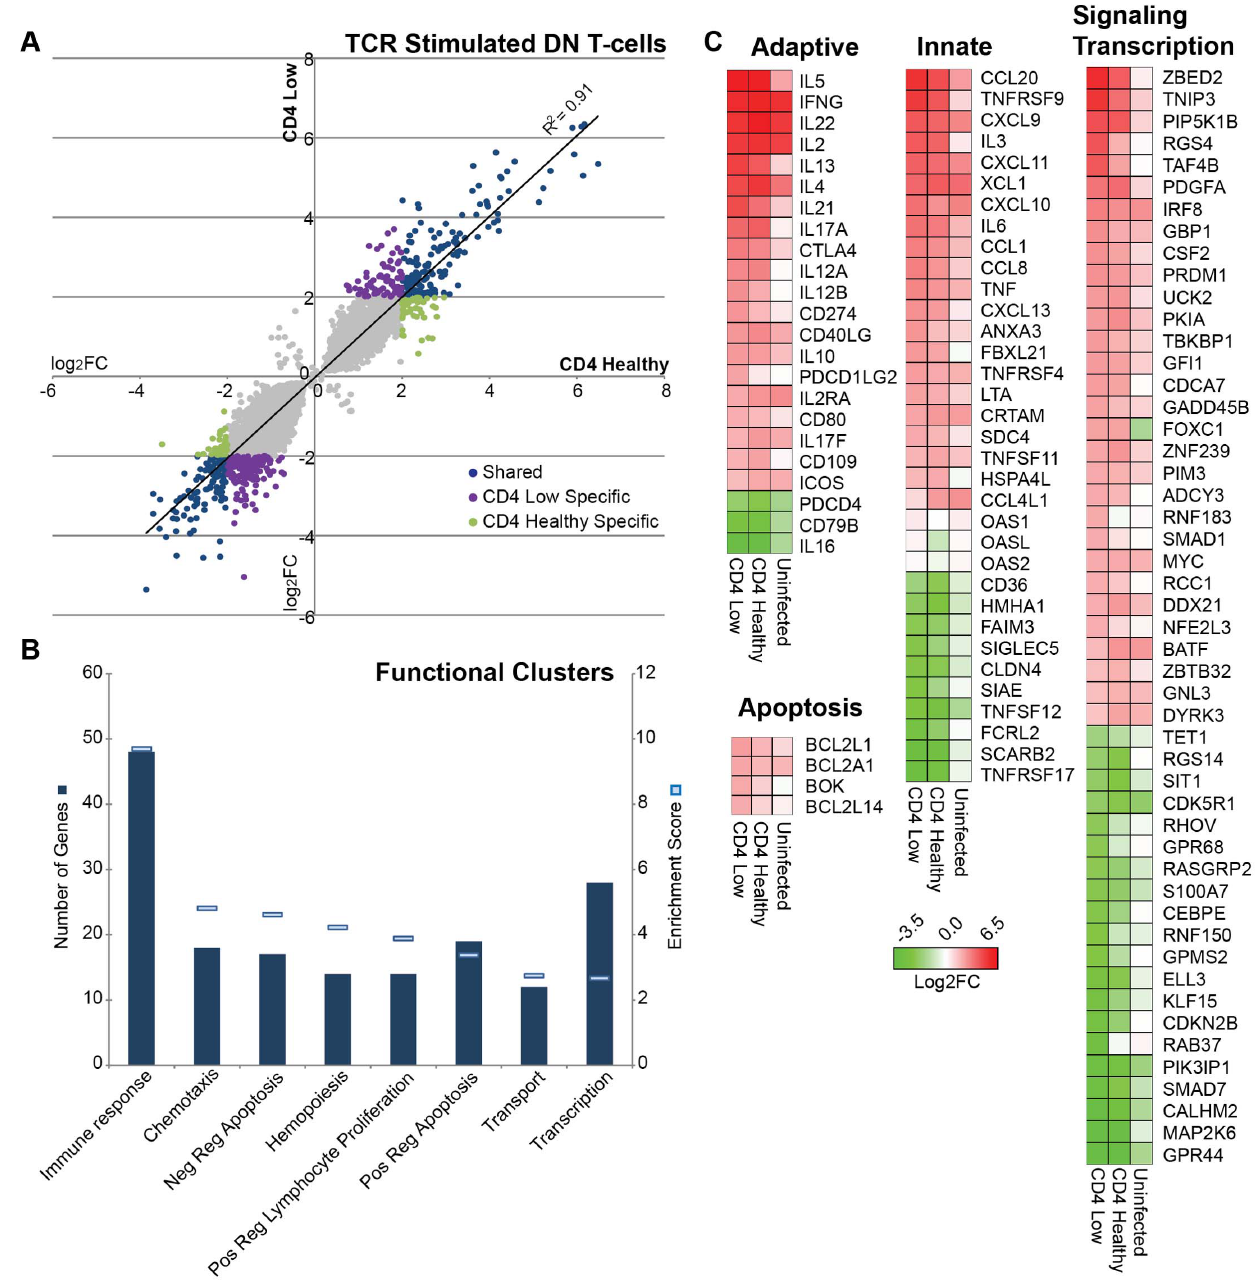
Figure 4. Transcriptome analysis utilizing microarray of TCR stimulated DN T cells from mangabeys depicts upregulation of transcription factors and immunomodulatory genes. Microarray analysis comparing TCR-stimulated and unstimulated DN T cells. A) DN T cells from two SIV + CD4-healthy and two SIV + CD4-low mangabeys were stimulated with anti-CD3/anti-CD28 and comparative mRNA expression of differentially regulated genes following stimulation of is depicted with less than 4 fold differential regulation depicted in grey, while those with greater than 4 fold differential expression depicted in color (n=568). In blue are genes regulated to the same extent in DN T cells from both SIV + CD4- low and SIV + CD4-healthy mangabeys, while genes specific to DN T cells from SIV + CD4-low animals are depicted in purple and those specific to DN T cells from SIV + CD4-healthy animals are in green. B) Enrichment data of functional clusters in gene families that are differentially regulated upon stimulation with number of genes shown as columns (dark blue) and extent of enrichment of functional gene clusters (enrichment score) depicted as lines (light blue). Genes involved in immune response and transcription were highly enriched. C) Evaluation of immunomodulatory genes with subsets representing adaptive immunity, innate immunity, apoptosis, signaling and transcription genes are presented as a heat map. Differentially regulated genes from SIV + CD4-healthy, SIV + CD4-low and uninfected mangabeys with $ 4 fold differential regulation following TCR stimulation depicting upregulated (red) and downregulated (green) gene expression.